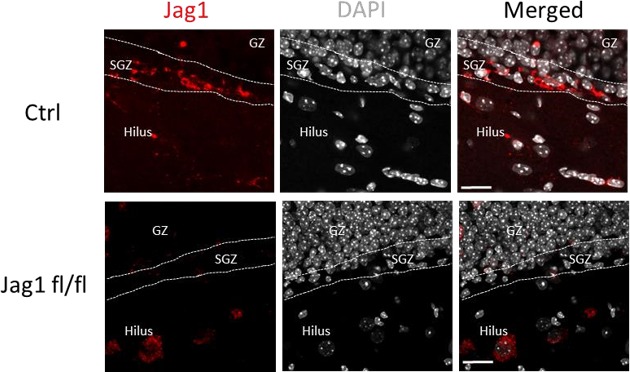
Jag1 signal is mostly eliminated from SGZ in iJag1fl/fl mice.Immunostaining for Jag1 expression using anti-Jag1 antibody (Santa Cruz Biotechnology, Santa Cruz, CA) shows that the signal is localized to both SGZ and hilus in control (Ctrl) samples, whereas it is present mostly in hilus in the conditional knockout mice and not in the SGZ. Method is described in Materials and methods section. Scale bar=20µm.